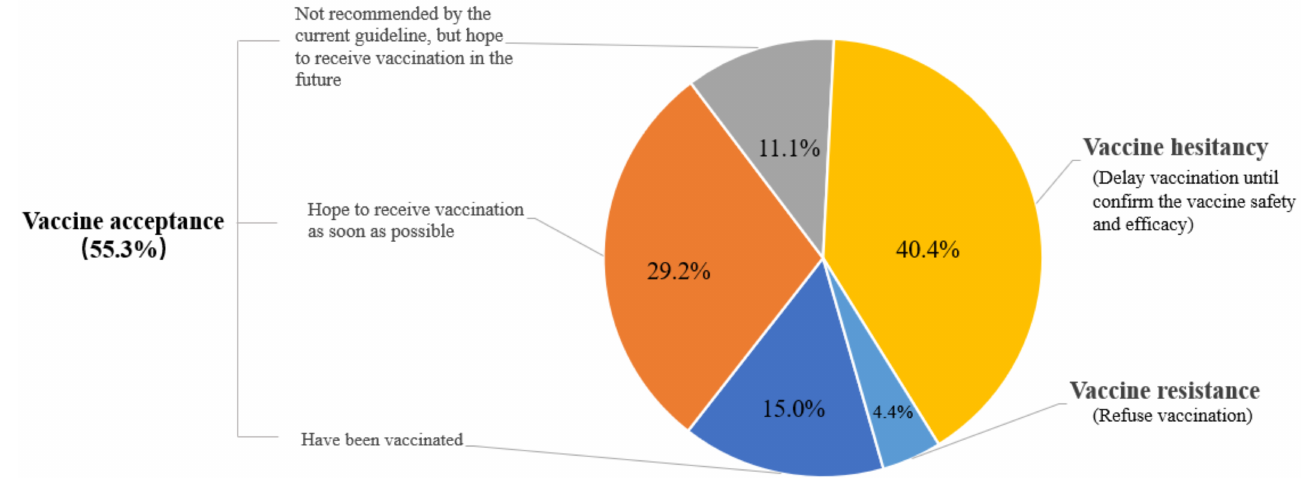
Figure 1. The prevalence of COVID-19 vaccination willingness. Table 2. Sociodemographic characteristics, epidemic-related factors, vaccination-specific factors, and health status of respondents by COVID-19 vaccination